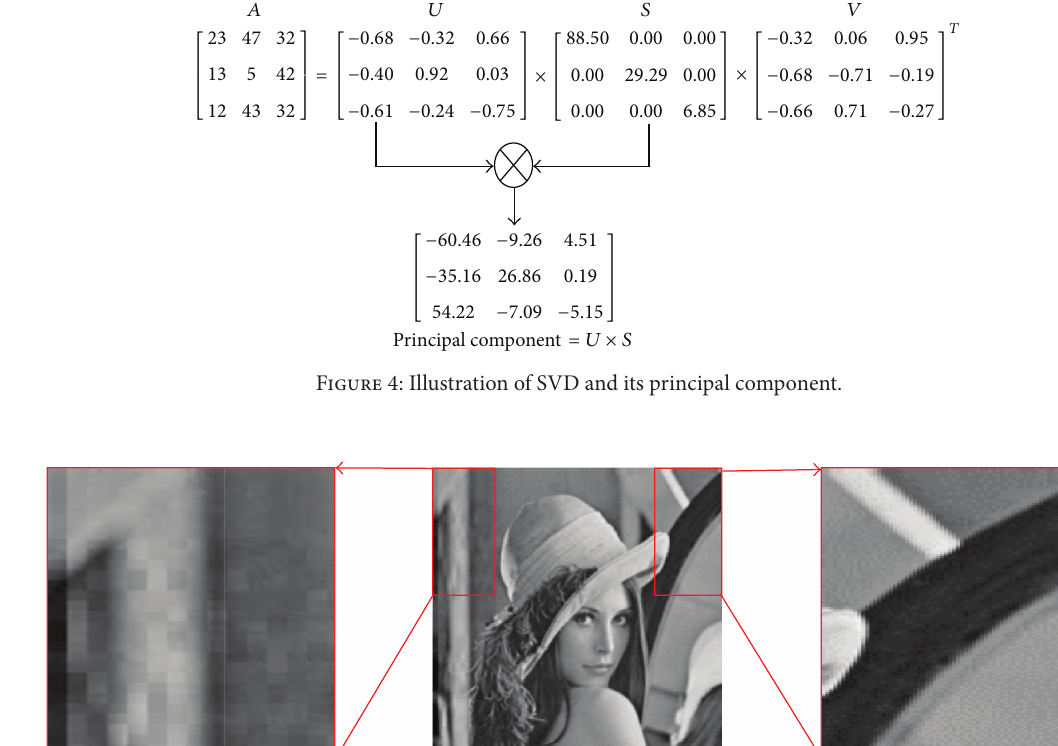
If |𝐵 21 | > |𝐵 12 | , where the term | ∗ | is the absolute value operator, then transpose the image RI to obtain the redistributed normalized image. To show this visually, we have taken an example of a square matrix of order 4 that is shown in Table 1. The block size is taken 2 × 2 to show the singular values of the blocks by applying SVD to both original and normalized versions, respectively. From this table it is clear that the singular values of the blocks of redistributed